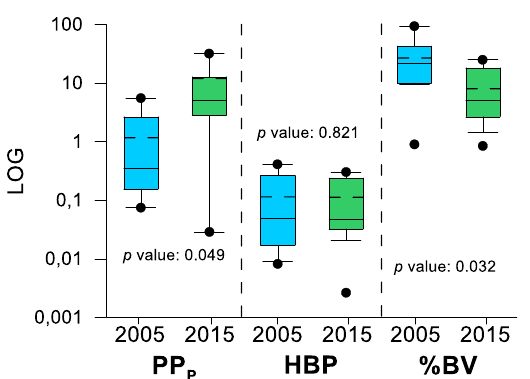
Figure 3. Box-Plot of particulate primary production (PP P ), heterotrophic bacterial production (HBP) and % bacterivory (%BV) in Lakes of Sierra Nevada. Full lines and discontinuous lines inside the box represent the median and mean value, respectively. The boxes represent the upper and lower quartiles, while vertical lines indicate the 10 th and 90 th percentiles, and the points the 5 th and 95 th percentiles. 2005 and 2015 data were significantly different (paired t- test for dependent samples analysis) for PP P and %BV with p value showed in the